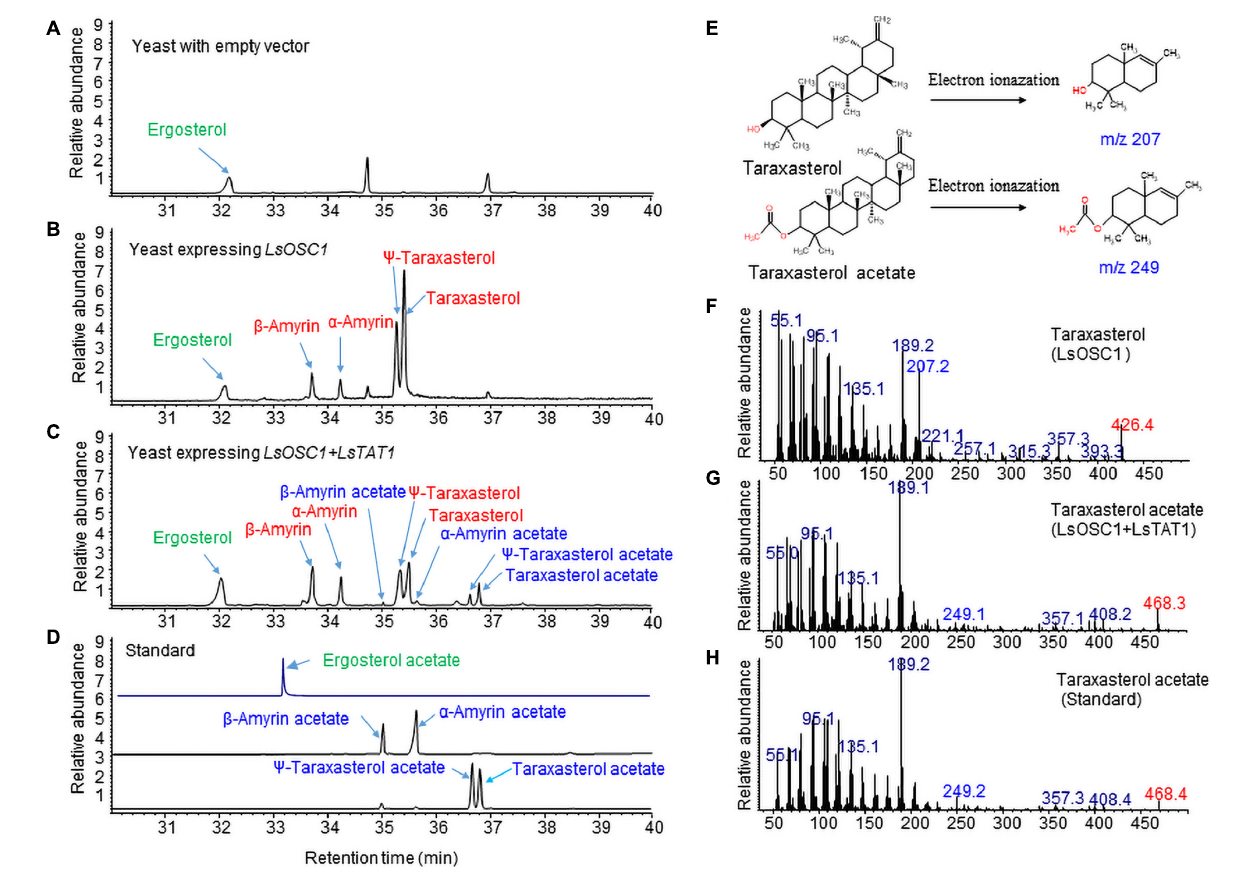
FIGURE 7 | Gas chromatography (GC) analysis of triterpene acetates extracted from yeast co-expressing both the LsOSC1 and LsTAT1 genes. (A) Chromatogram of control yeast transformed with the empty vector. (B) Chromatogram of triterpene products ( β -amyrin, α -amyrin, ψ -taraxasterol, taraxasterol, and dammarenediol-II) in yeast transformed with LsOSC1 . (C) Chromatogram of two triterpene acetates (taraxasterol acetate and ψ -taraxasterol acetate) in yeast transformed with both the LsOSC1 and LsTAT1 genes. (D) GC chromatograph of authentic standards of β -amyrin acetate, α -amyrin acetate, ψ -taraxasterol acetate, and taraxasterol acetate. (E) Structures of taraxasterol and taraxasterol acetate and their mass fragment ions by Electron Ionization-mass spectrometry (EI-MS). (F) MS spectrum of taraxasterol produced in yeast expressing LsOSC1 . (G) MS spectrum of taraxasterol acetate produced in yeast expressing LsOSC1 and LsTAT1 . (H) MS spectrum of the taraxasterol acetate